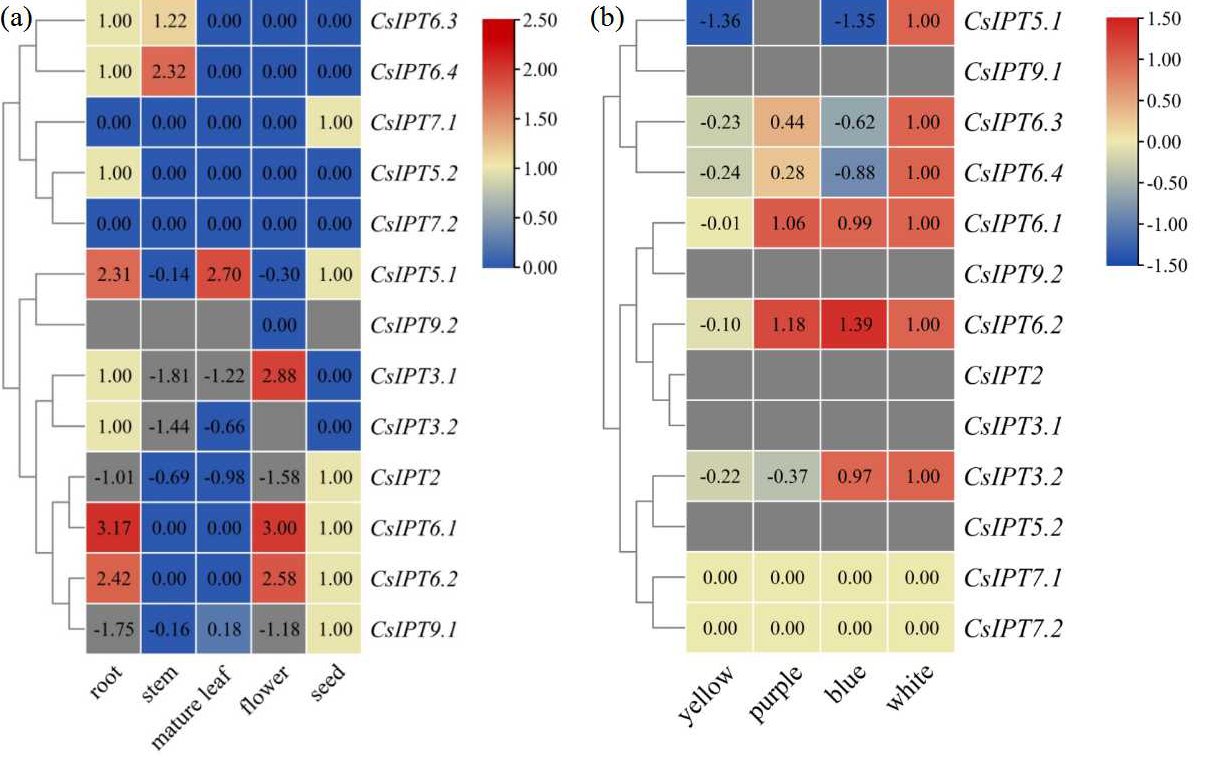
Figure 4. Expression profiles of CsIPT genes in different tissues ( a ) and to different light treatments ( b ) in tea plants. ( b ) in tea